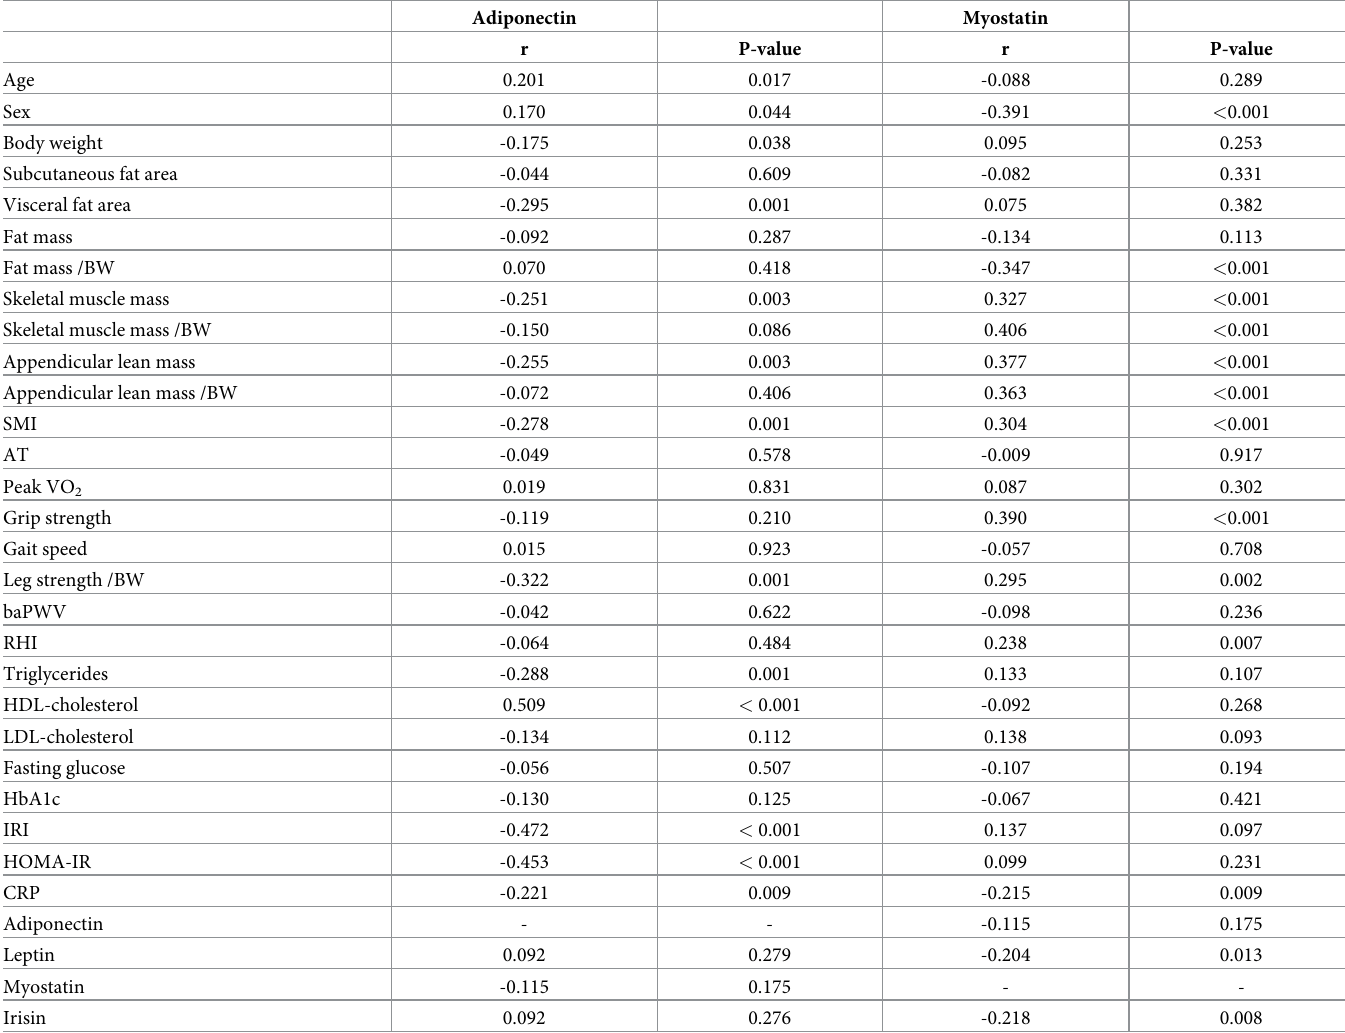
Table 2. Correlation of adiponectin and myostatin with anthropometric and metabolic